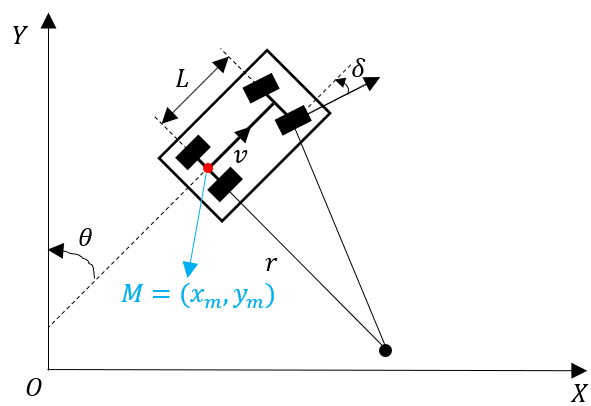
Figure 1. The kinematic model of autonomous agricultural machinery.